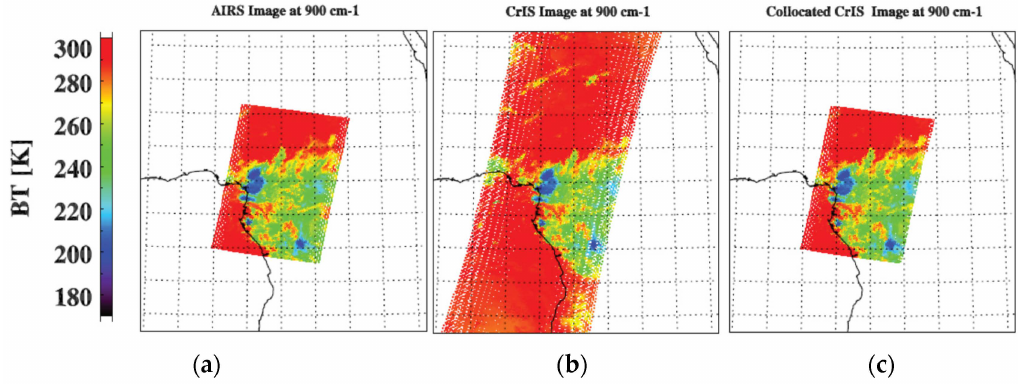
Figure 11. Examples of CrIS ( a ) and AIRS ( b ) images at 900 cm − 1 as well as a collocated CrIS image that matches AIRS ( c